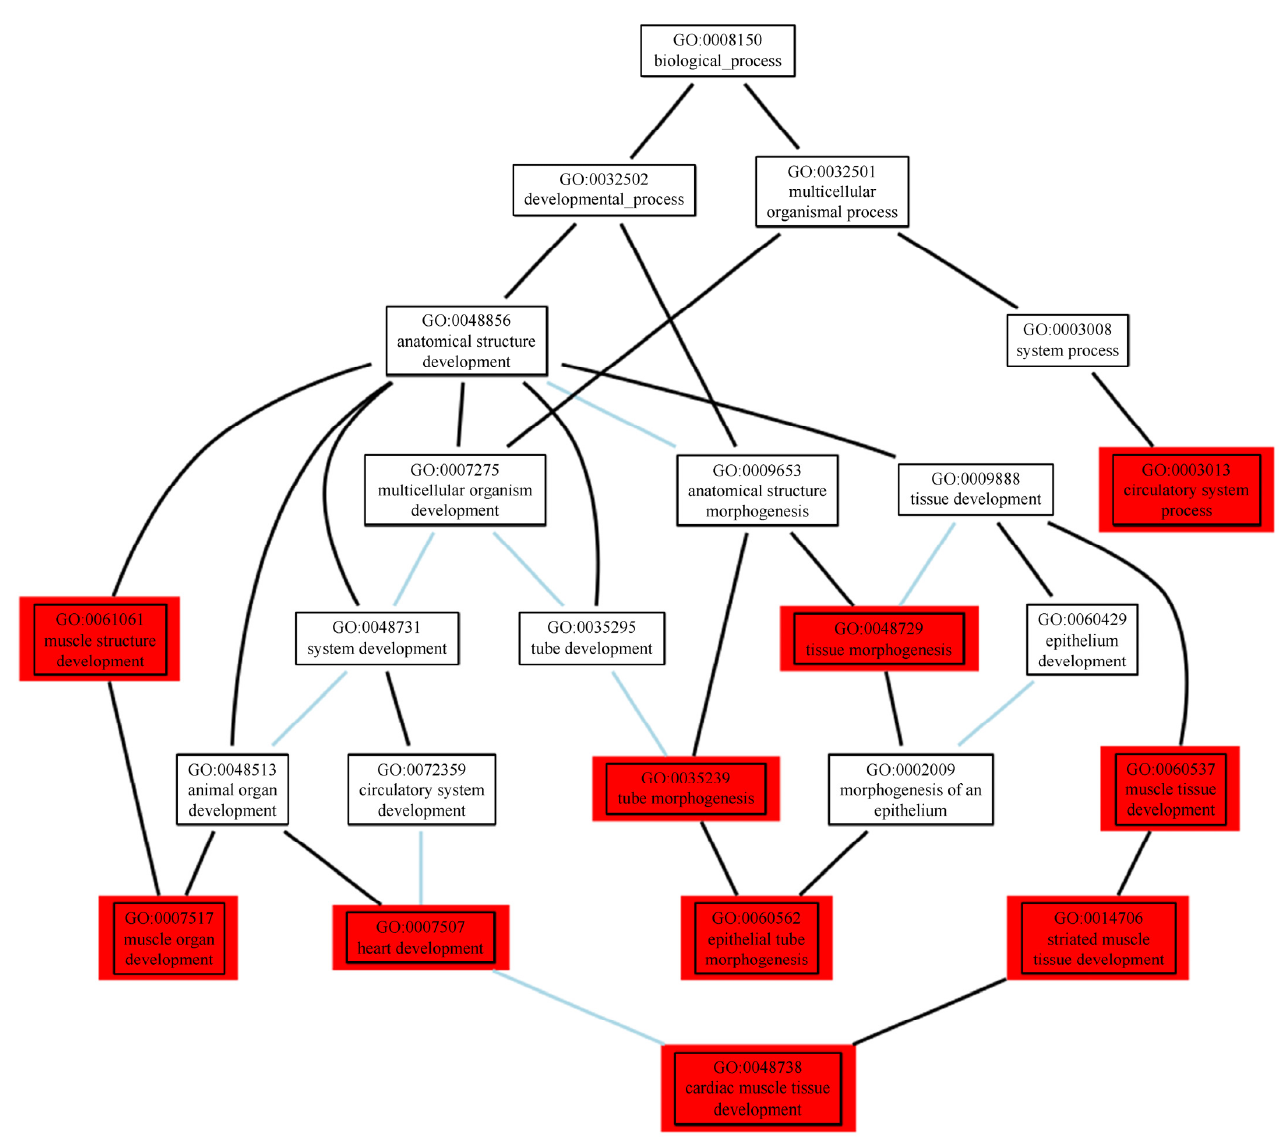
Figure 4. Hierarchical relationships of the top 10 enriched pathways for BP in a Gene Ontology (GO) tree. Black connectors mean “is a” and blue connectors mean “part of”. Coloured in red are the top 10 significantly enriched (FDR < 0.01) GO terms.